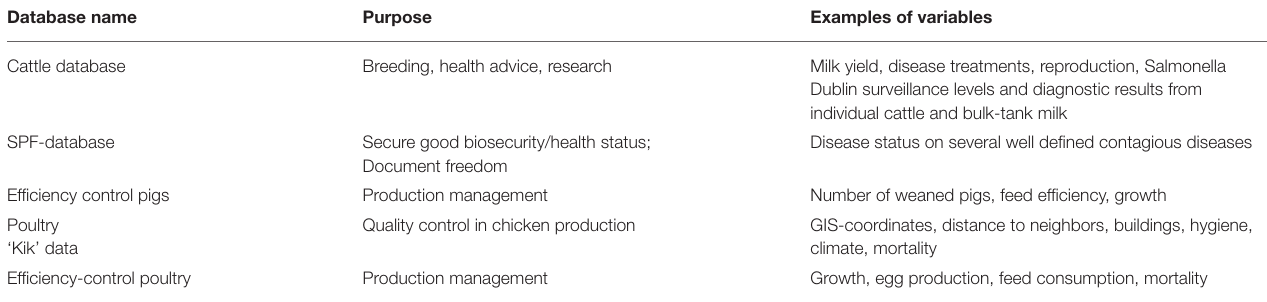
TABLE 3 | Databases in Denmark owned by the industry or privately owned.